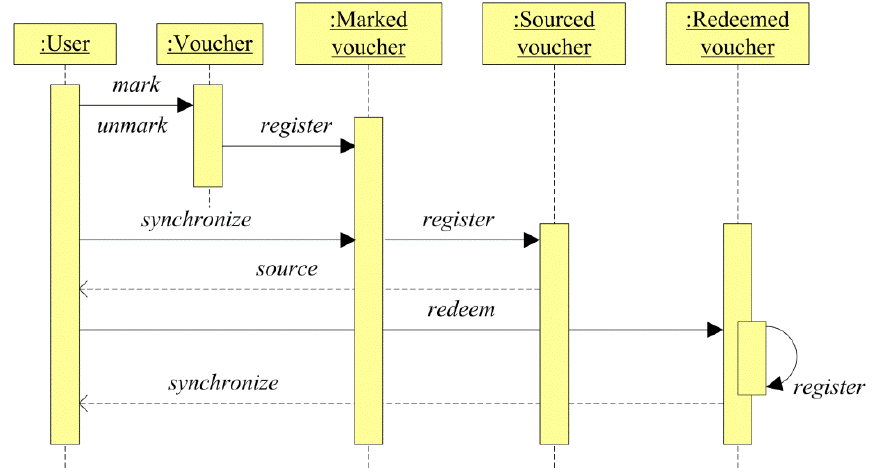
Figure 2. Sequence diagram showing the voucher